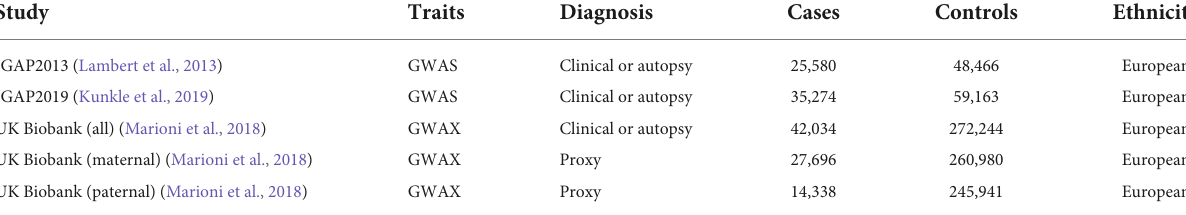
TABLE 1 Data sources of GWAS.